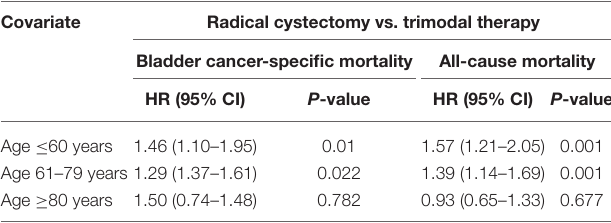
TABLE 4 | Proportional hazards regression model for all-cause mortality and bladder cancer-specific mortality according to treatment type, stratified by age. Covariate Radical cystectomy vs. trimodal